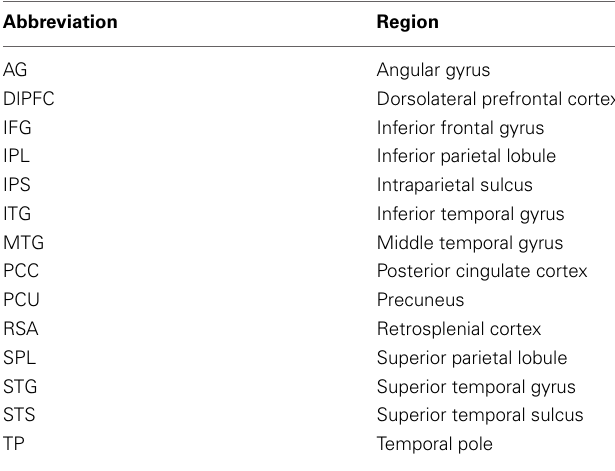
Table 1 | Abbreviations of neural